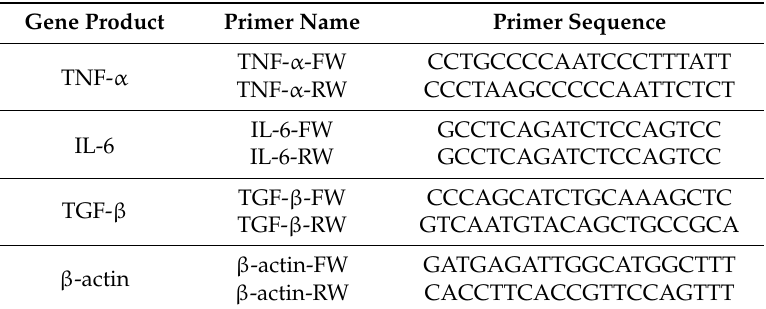
Table 1. List of primers used in this